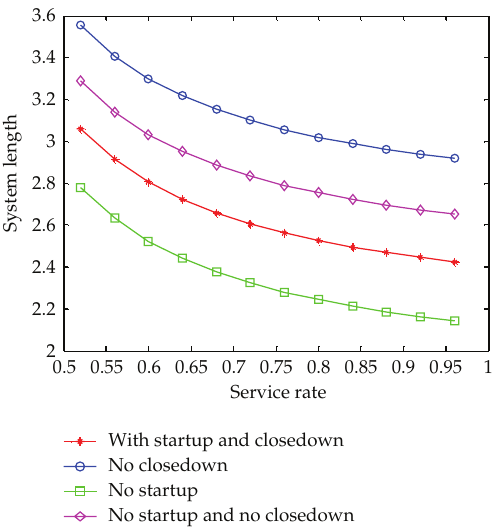
Figure 4: Plot of mean length in the system versus service rate with λ (cid:5) 0 . 3, N ∼ Geo (cid:3) 0 . 3 (cid:4) , S ∼ Geo (cid:3) 0 . 4 (cid:4) , C ∼ Geo (cid:3) 0 . 5 (cid:4) , and B ∼ Geo (cid:3) α (cid:4) , the values of service rate α varying from 0.52 to 096 by the increment